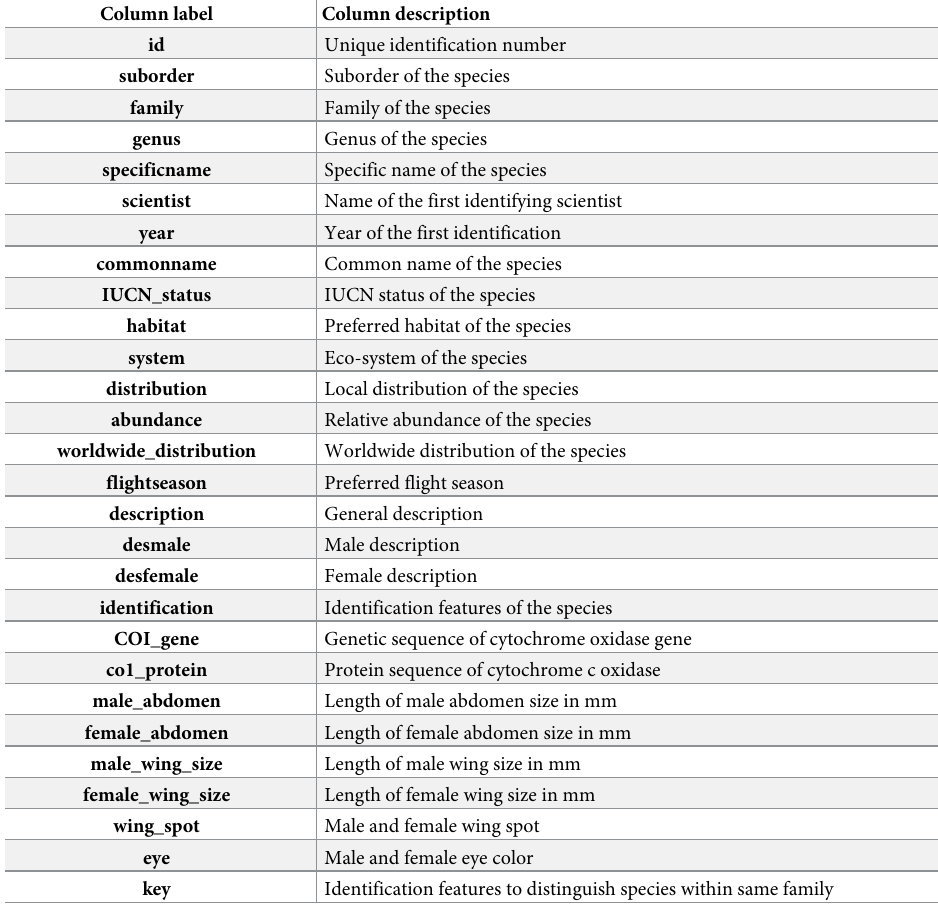
Table 1. Data structure and variable definition of OdoBD_biology dataset.